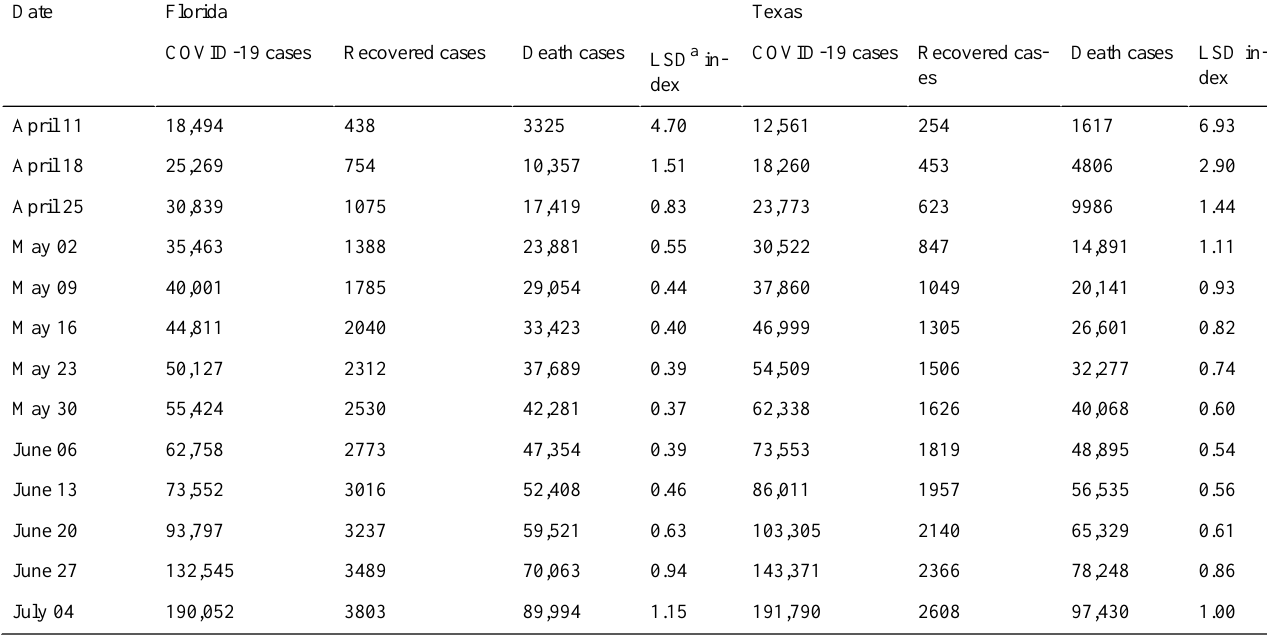
Table 2. Resurgence of COVID-19 epidemic in Florida and